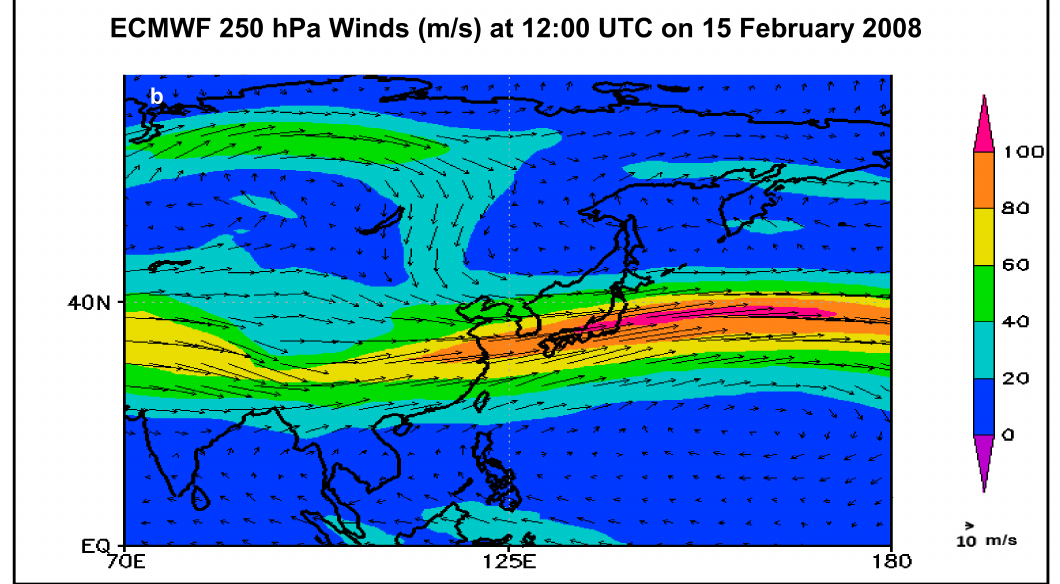
Figure 6. JS over East Asia towards Northern Pacific at 250 hPa ( a ) at 18:00 UTC 26 January 2008 and ( b ) at 12:00 UTC 15 February 2008. Data from the ECMWF,